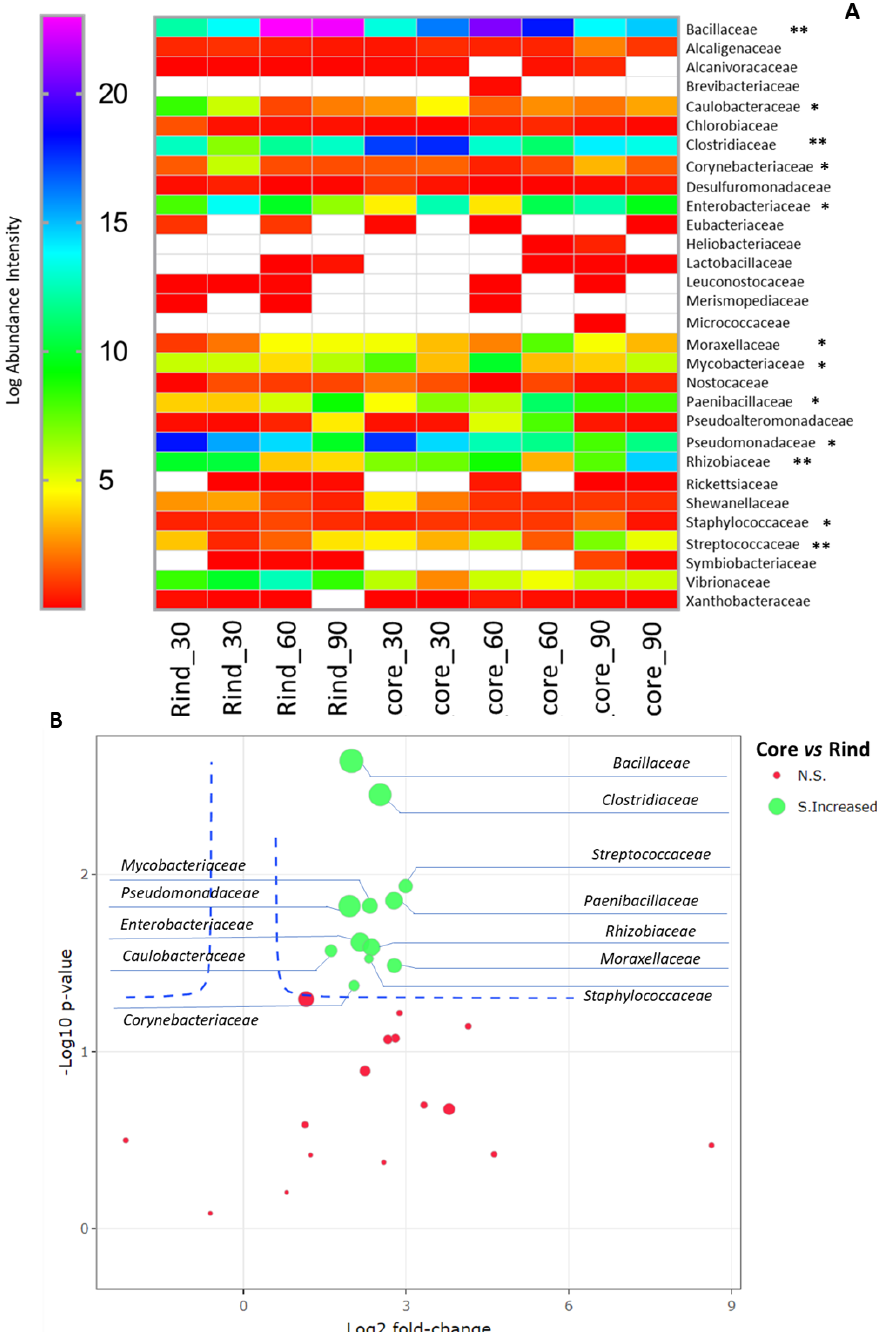
Figure 4. Microbiota composition based on the identified protein repertoire. ( A ) Quantitative composition of the microbial communities harbored in the rind and core of the cheese wheel at 30, 60, and 90 days of ripening. T-tests on a sample group basis (i.e., rind and core) were performed to highlight the contributors to the statistically significant differences in the structure of the microbiota between the rind and the core. Single and double asterisks indicate p < 0.05 and p < 0.01, respectively. ( B ) Volcano plot summarizing the bacterial families significantly overrepresented in the core samples (green circles) according to the T-test analysis. Non-statistically significant bacterial families are represented by red circles. The average intensity of each bacterial family is indicated by the diameter of its